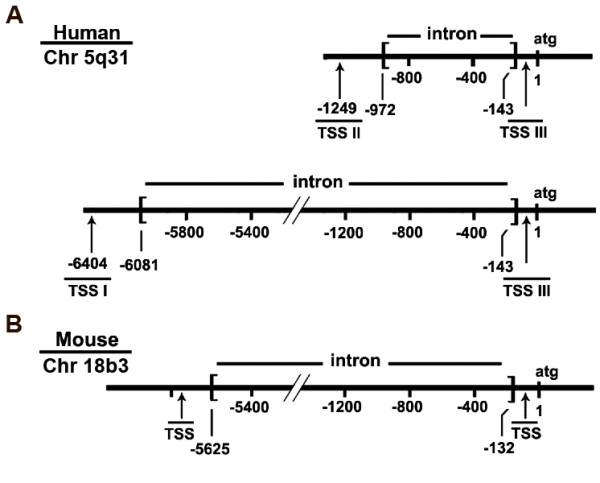
Comparison of human (A) and mouse (B) PURA transcriptional start sites and 5' untranslated regions. Three distinct transcriptional start sites (TSSs) initiate transcription of human PURA. Human and mouse EST databases were utilized to determine TSSs of PURA. Numbering is from the A in the translationally- initiating ATG. A. TSS I - III are shown for humans. B. Two TSSs as determined from ESTs are shown for mouse. The one most distant from ATG has previously been identified [28]. The new mouse TSS is very homologous to human TSS III, which is verified in this report. Human transcripts starting at sites I and II are characterized by introns of dissimilar lengths, as indicated in A. The genomic locations of human and mouse PURA are given.